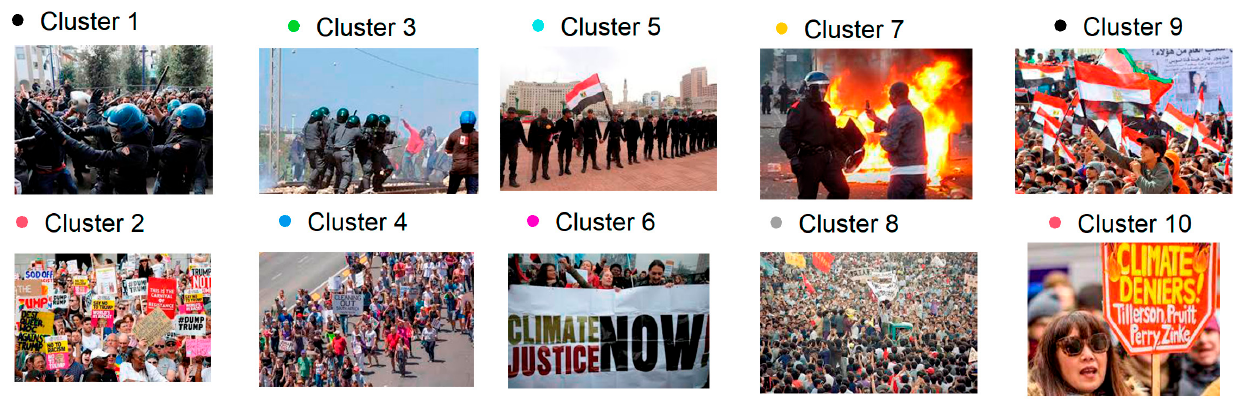
Figure 6. t-SNE representation of points corresponding to digital images of demonstrations.